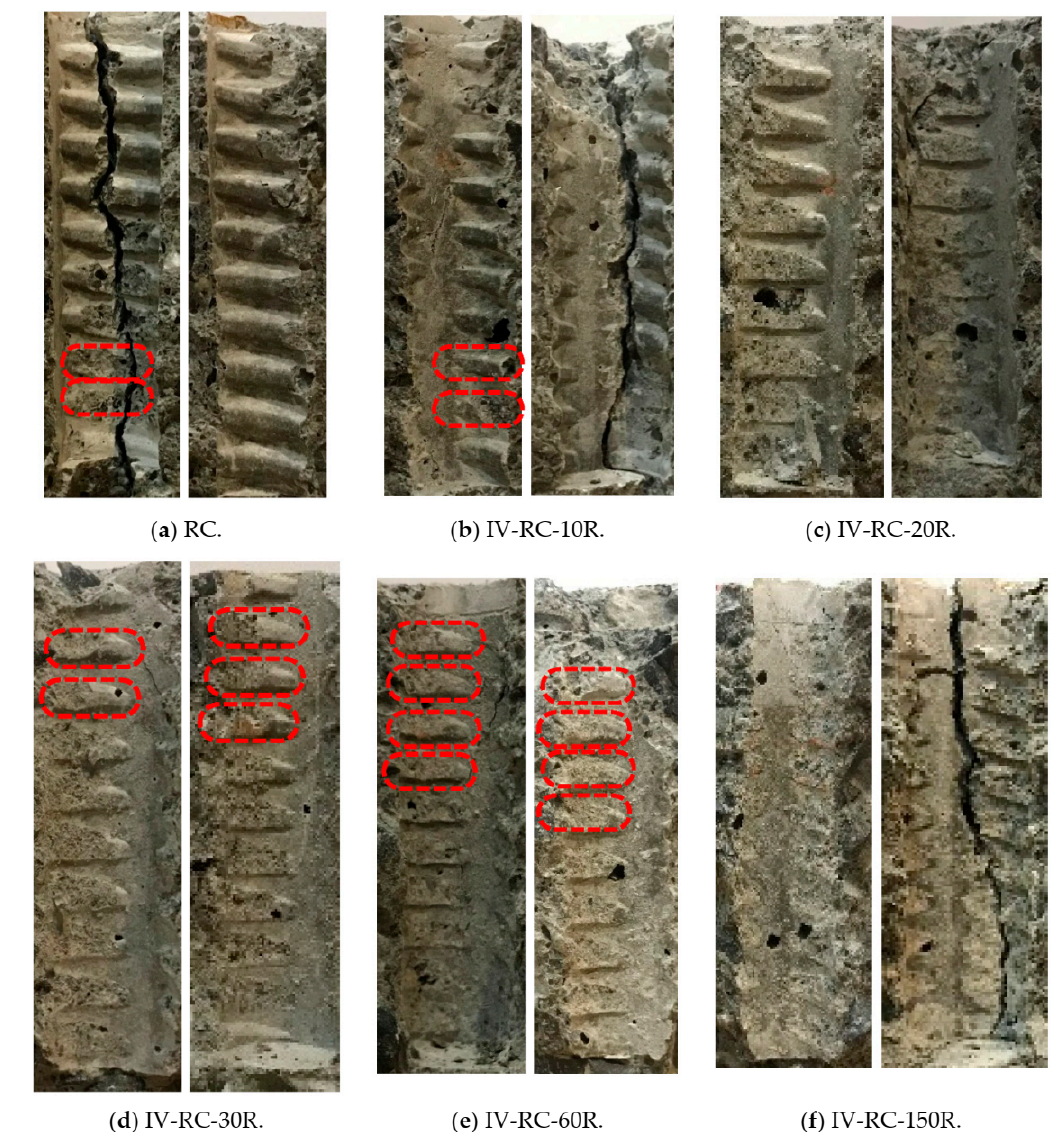
Figure 18. Matrix/steel bar interface for series IV specimens after pullout